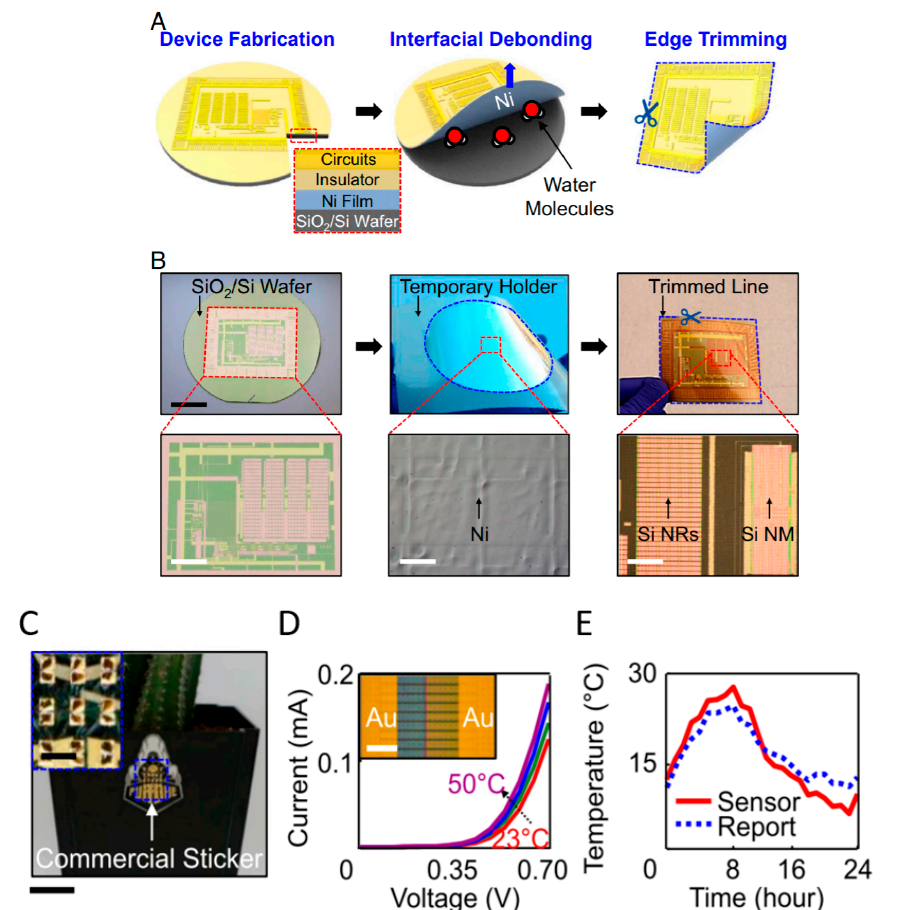
Figure 43. ( A ) Key steps of the fabrication and debonding of thin-film nanoelectronics from conventional Si wafers; Inset: cross-sectional view of the successive layers. ( B ) Optical images of the thin films: (left), on the wafer (scale bar: 2.5 cm); (middle), peeled with a thermally releasable tape; (right) trimmed. ( C ) Optical image of arrays of a Si -based temperature sensor pasted on the surface of a cactus pot (scale bar: 2 cm). Inset: magnified view of the sensor sticker. ( D ) Corresponding electrical characteristics for a temperature ranging from 23 to 50 ◦ C. Inset: micrograph of the sensor (scale bar: 150 µ m). ( E ) Environmental temperature measured by the above sensor, compared with a local weather report over a period of 24 h. Adapted from [173] with permission.